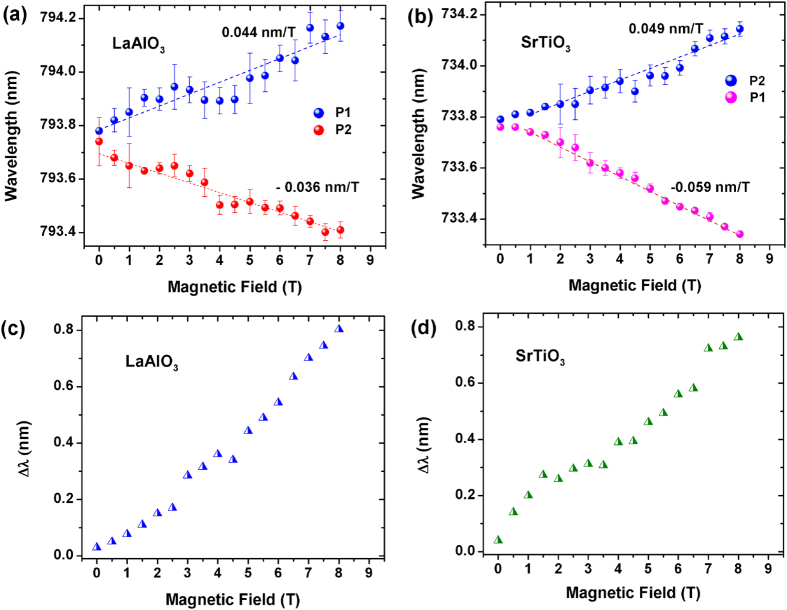
Variation of Peak Position with Magnetic Field for (a) LaAlO3 and (b) SrTiO3 has been plotted from 0 T to 8 T. The difference in the peak positions as a function of magnetic field is plotted for (c) LaAlO3 and (d) SrTiO3. We see a clear linear behaviour of this peak shift with magnetic field.